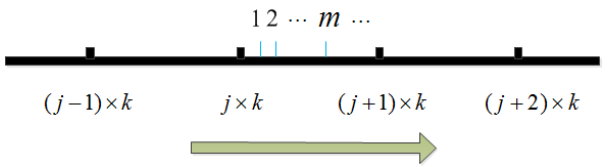
Figure 2. Undi ff erenced (UD) and epoch-di ff erenced (ED) processing Figure 2. Undifferenced (UD) and epoch-differenced (ED) processing schema.